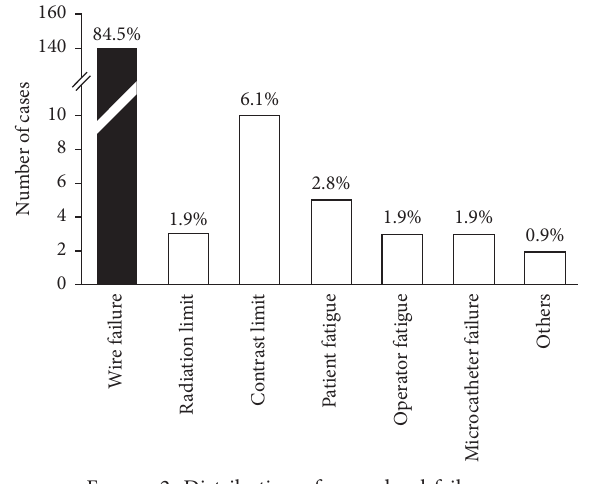
Figure 2: Distribution of procedural failures.